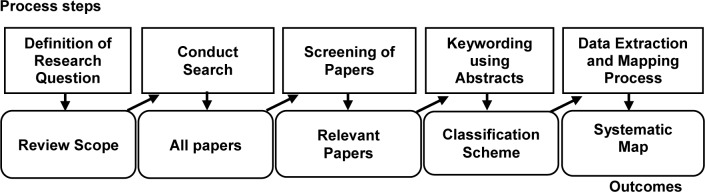
The process steps of systematic mapping [12].